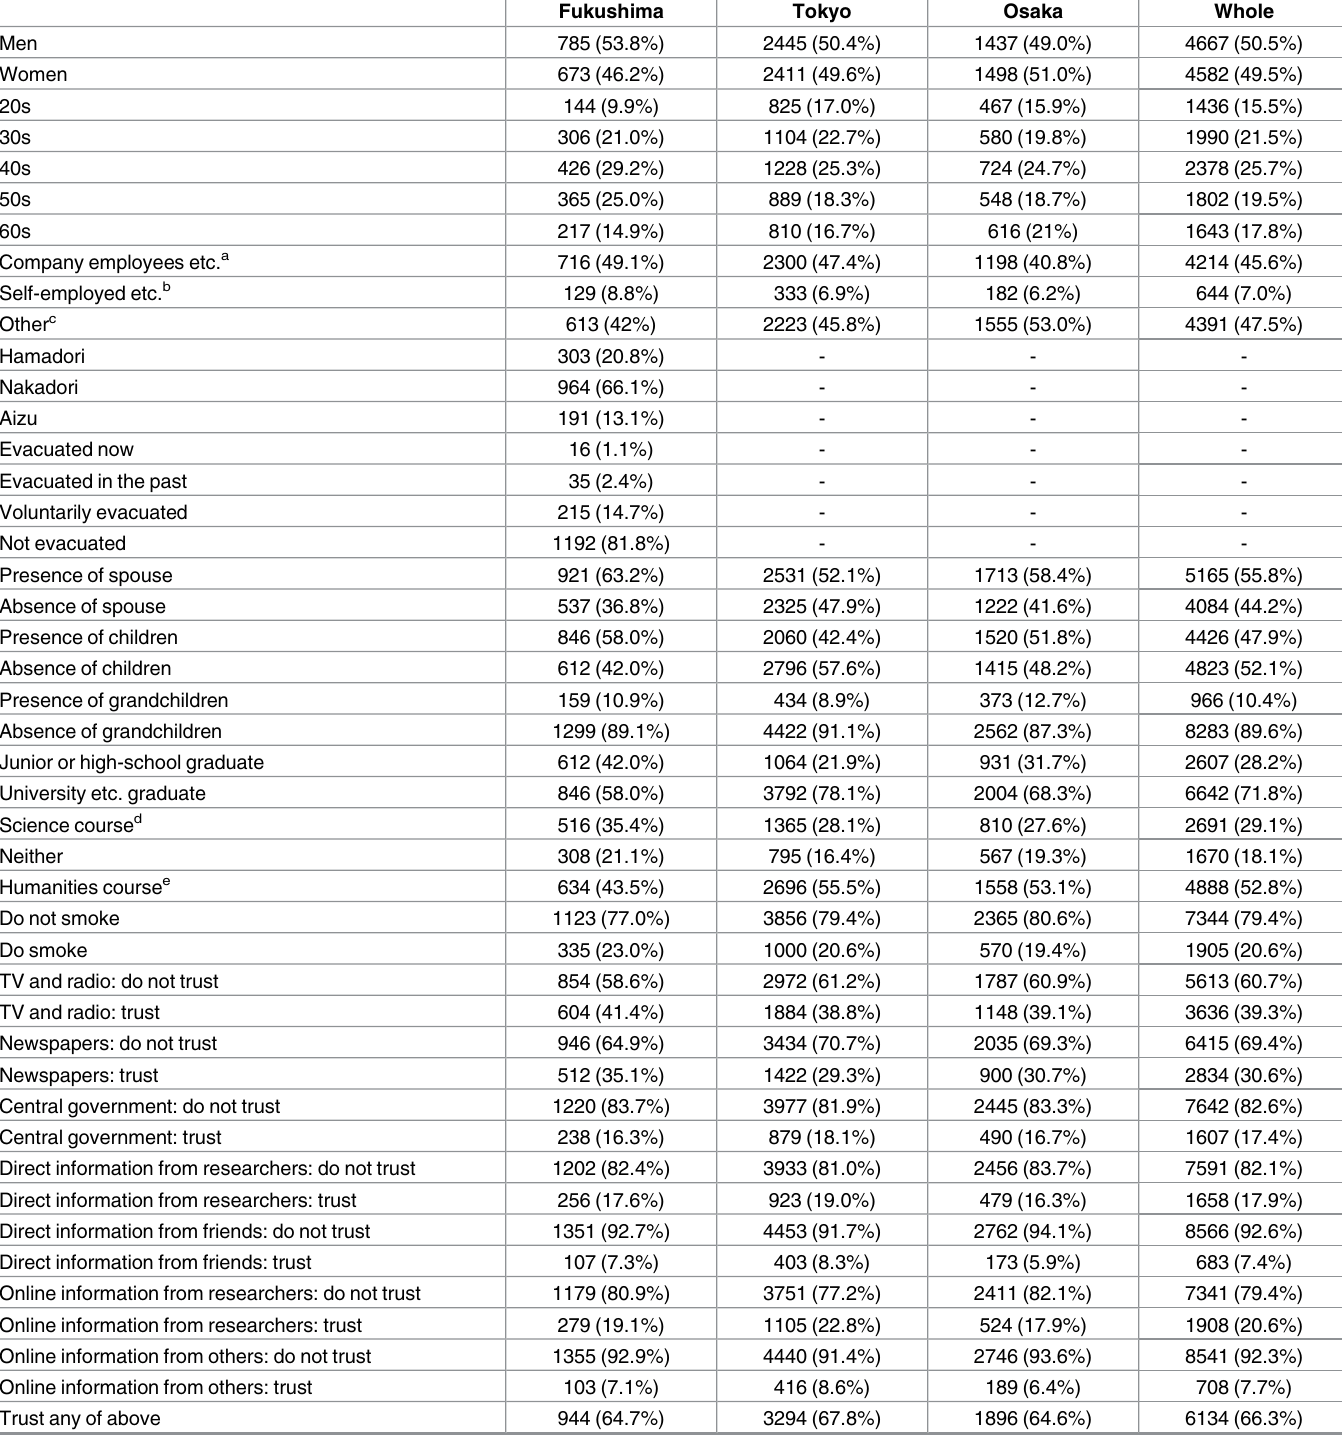
Table 1. Basic information on